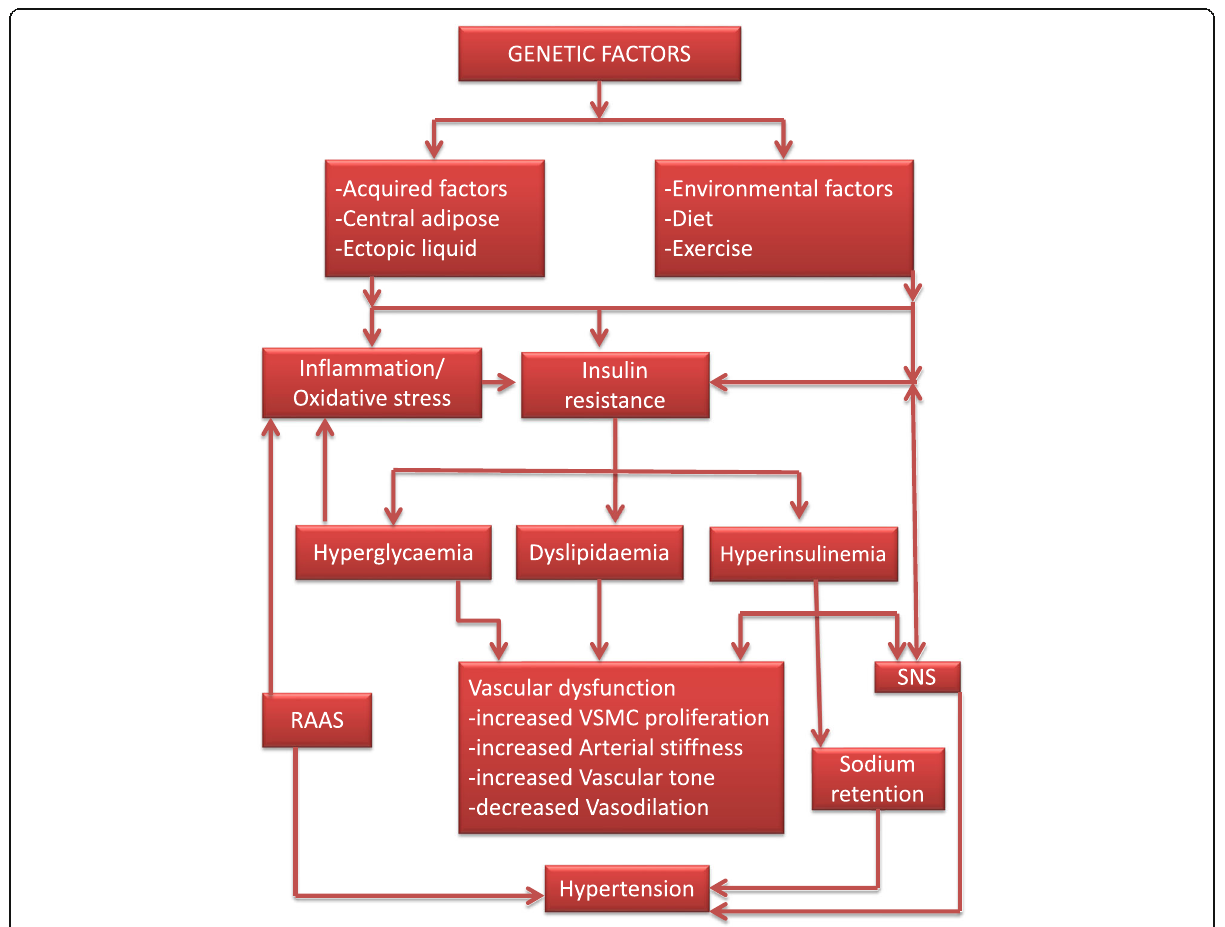
Fig. 2 Summary of pathophysiologic mechanisms in the development of hypertension in diabetes mellitus (VSMC — vascular smooth muscle cell)